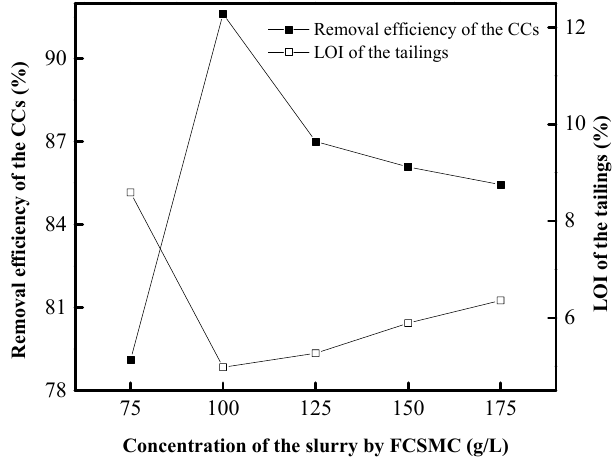
Figure 8. Effect of the slurry concentration on decarburization by FCSMC: kerosene = 3.5 g/kg·ash, MIBC = 0.2 g/kg·ash, Tween 80 = 7.5% of kerosene concentration, and pump speed = 380 r/min.